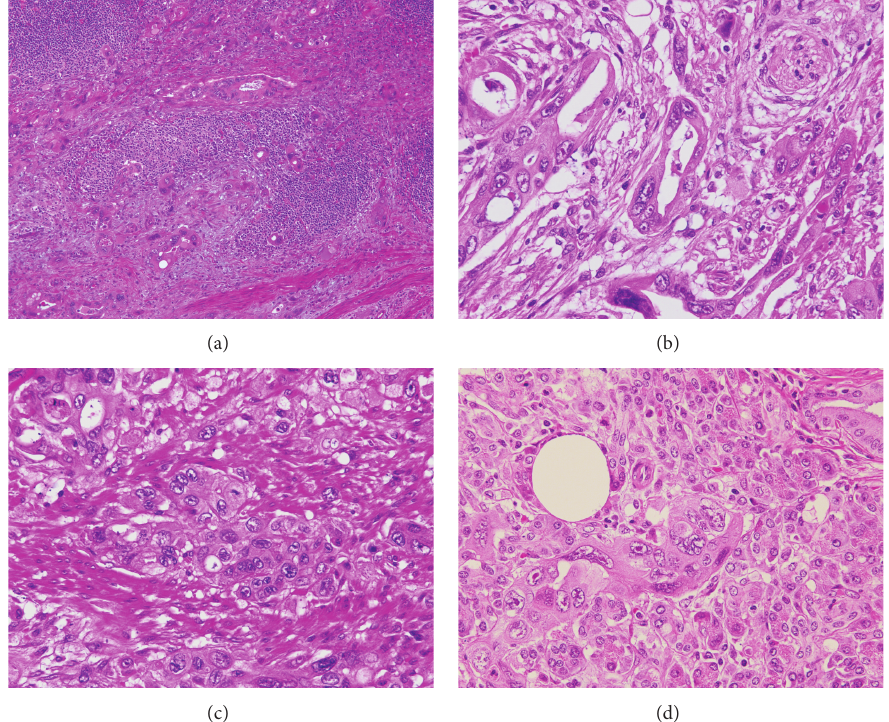
Figure 7: Representative histologic images of adenocarcinoma of the ampulla of Vater. ((a)–(d)) Follicles of follicular lymphoma are partially invaded by adenocarcinoma (a). Adenocarcinoma shows various patterns, including tubular (b), cribriform, and trabecular structure and nests (c), which invade the pancreas